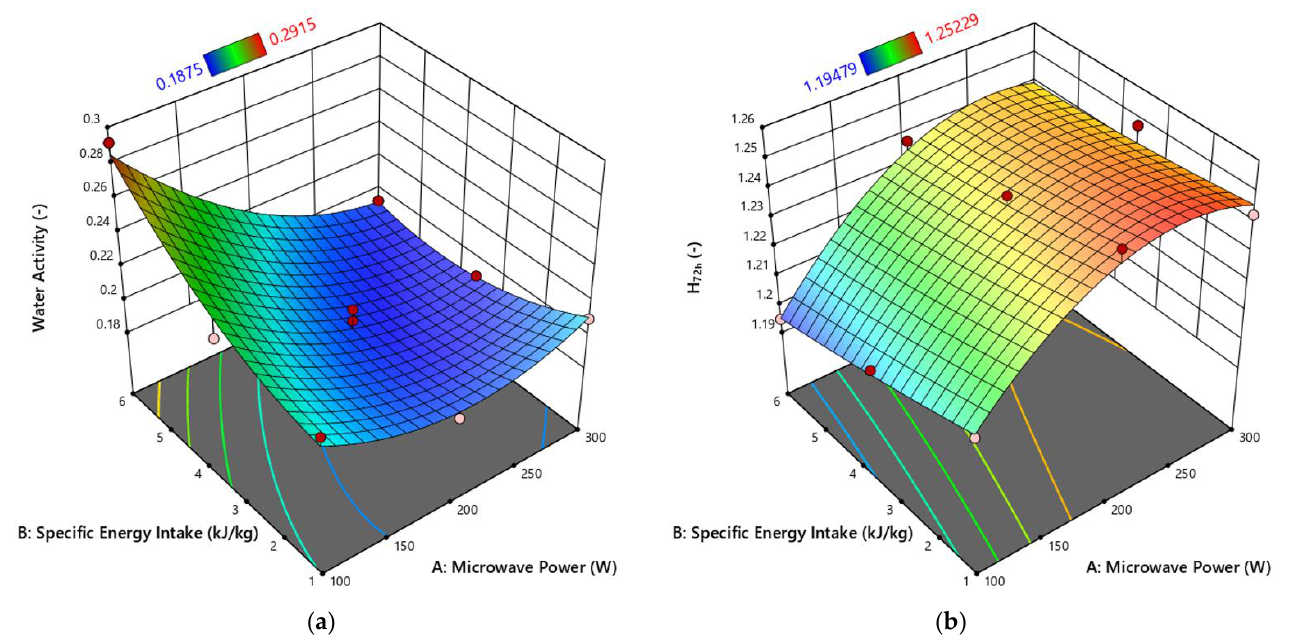
Figure 3. Response surfaces of: ( a ) water activity; ( b ) hygroscopicity after 72 h ( H 72 h ) of apples treated with PEF prior to microwave-convective drying, depending on the microwave power (factor A) and specific energy intake (factor B).